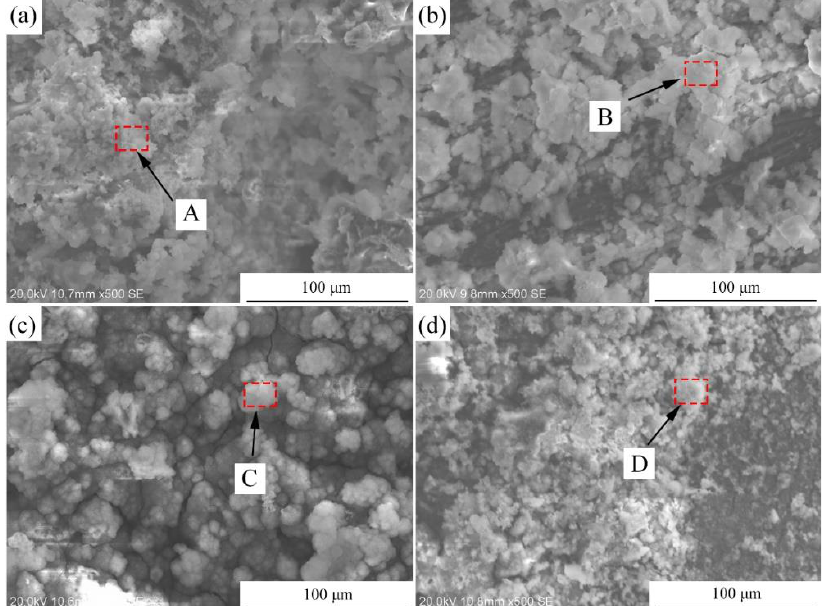
Figure 12. Corrosion morphologies of the four-pass extrusion alloys after 14 days of immersion in Hank’s solution with corrosion products: ( a ) Mg-2Zn-0.5Zr alloy; ( b ) Mg-2Zn-0.5Gd-0.5Zr alloy; ( c ) Mg-2Zn-0.5Nd-0.5Zr alloy; and ( d ) Mg-2Zn-0.5Y-0.5Zr alloy. Table 8. Chemical composition of the areas marked in Figure 10.